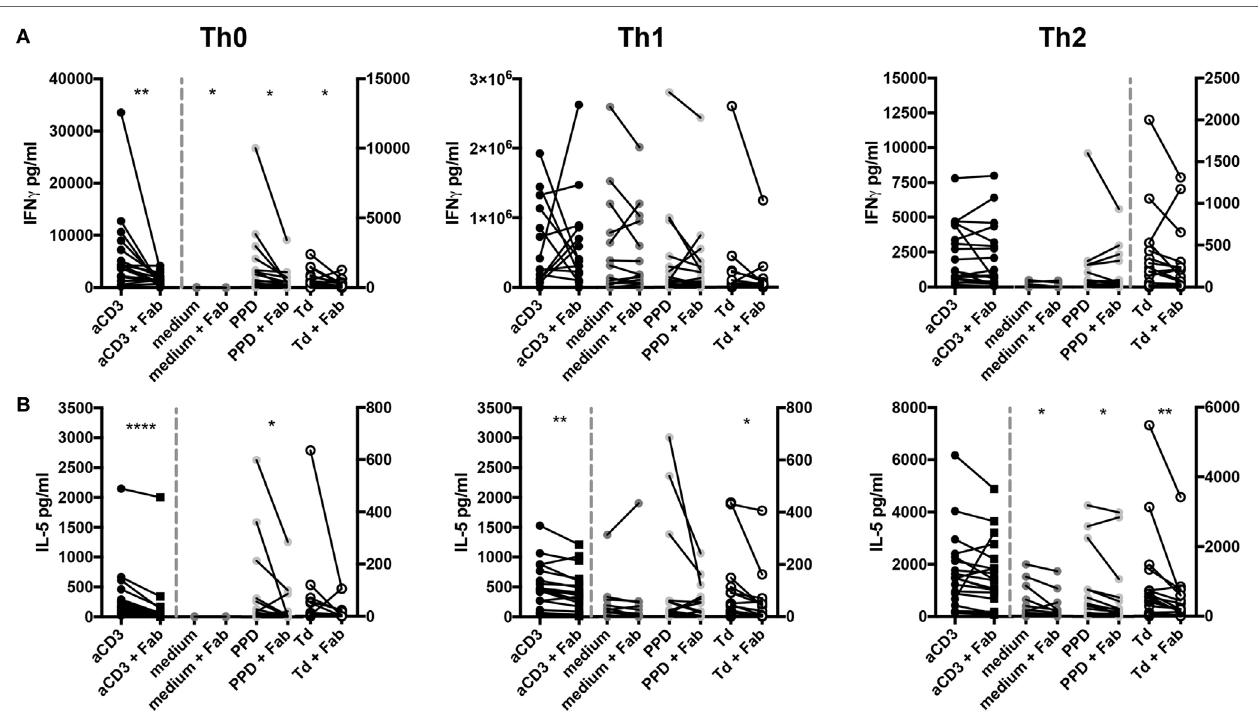
FigUre 7 | CD28 costimulation enhances cytokine release from peripheral blood mononuclear cells (PBMCs) upon antigenic recall stimulation with purified protein derivative or tetanus and diphtheria toxoid in vitro. (a) Interferon γ (IFN γ ) and (B) interleukin-5 concentrations in supernatants of experiments are first shown in Figure 4 , i.e., under Th0 (left), T helper (Th1) (middle), or Th2 (right) culture conditions. Please note that for human T cells Th1 conditions did not comprise addition of an anti-IFN γ antibody as was the case for mouse Th1 conditions. Graphs show data from 19 donors assayed individually and tested with a one-tailed paired t -test (* p < 0.05, ** p <